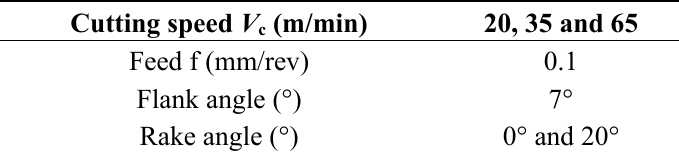
Table 4. Cutting conditions.